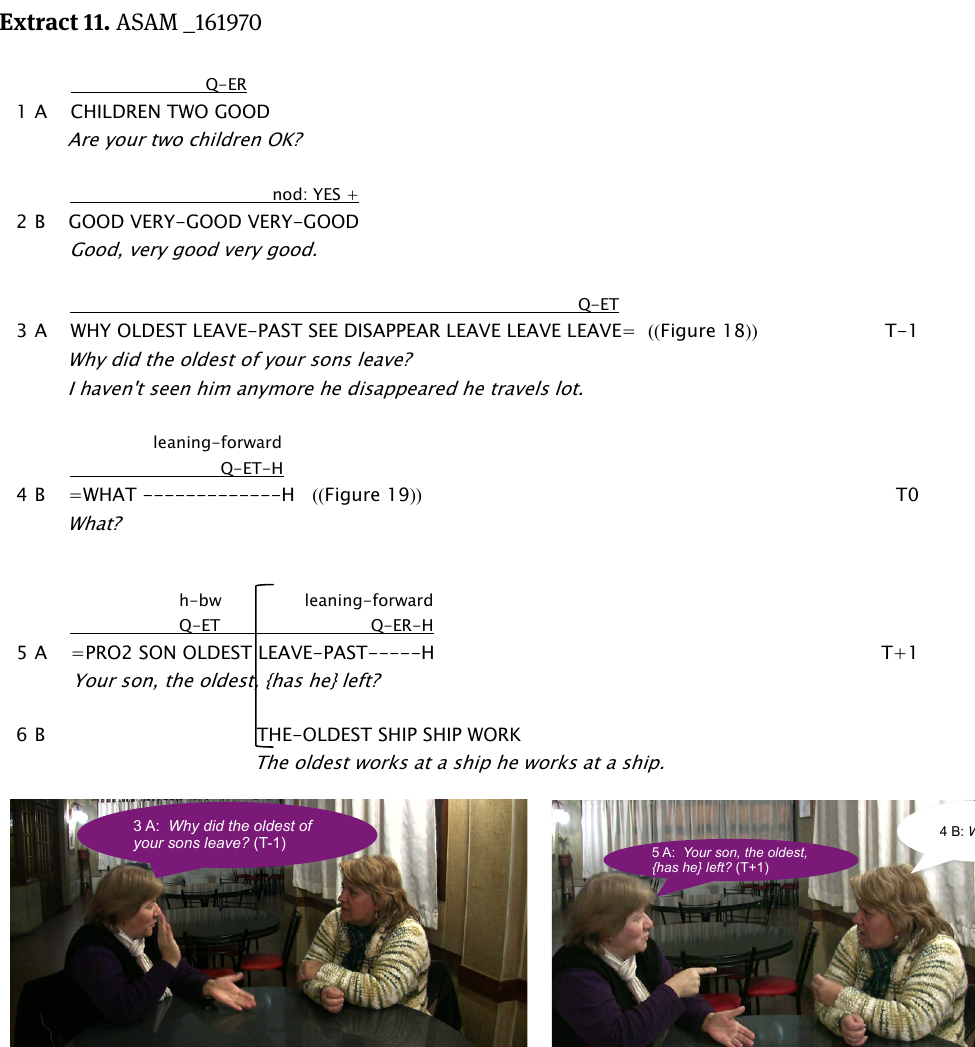
Figure 18. ‘Why did the oldest of your sons leave? ’, Person A (left) asks Person B (right) a question, line 3 (T-1).